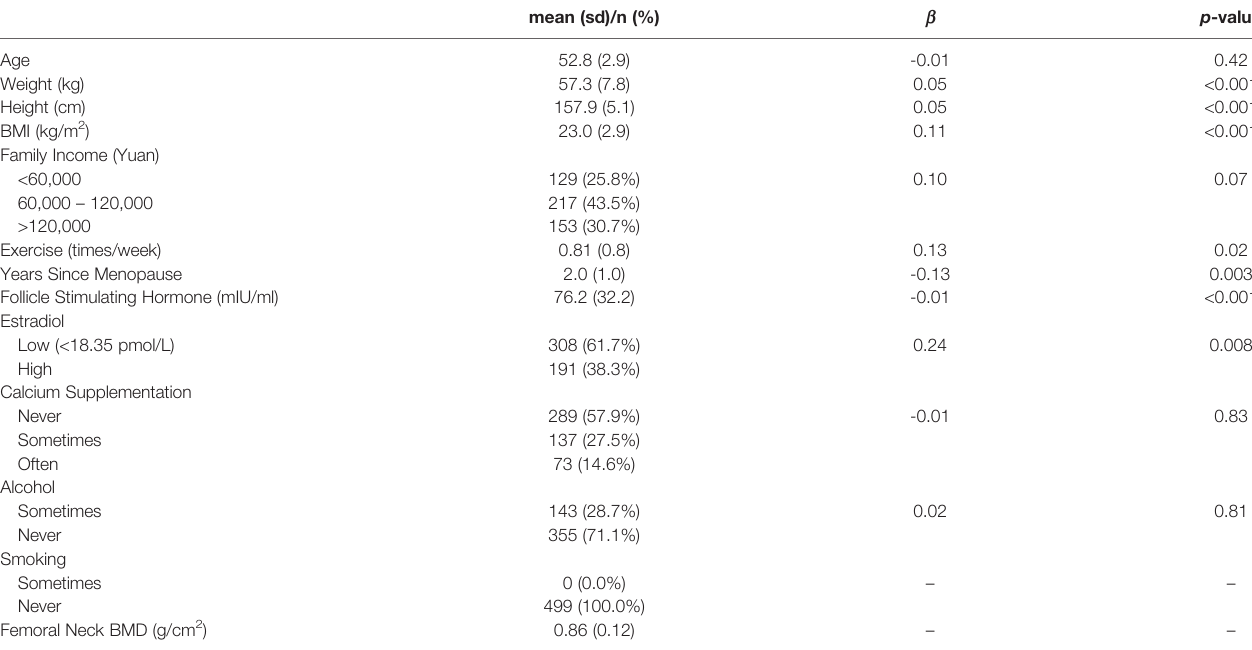
TABLE 1 | Sample Characteristics (n =